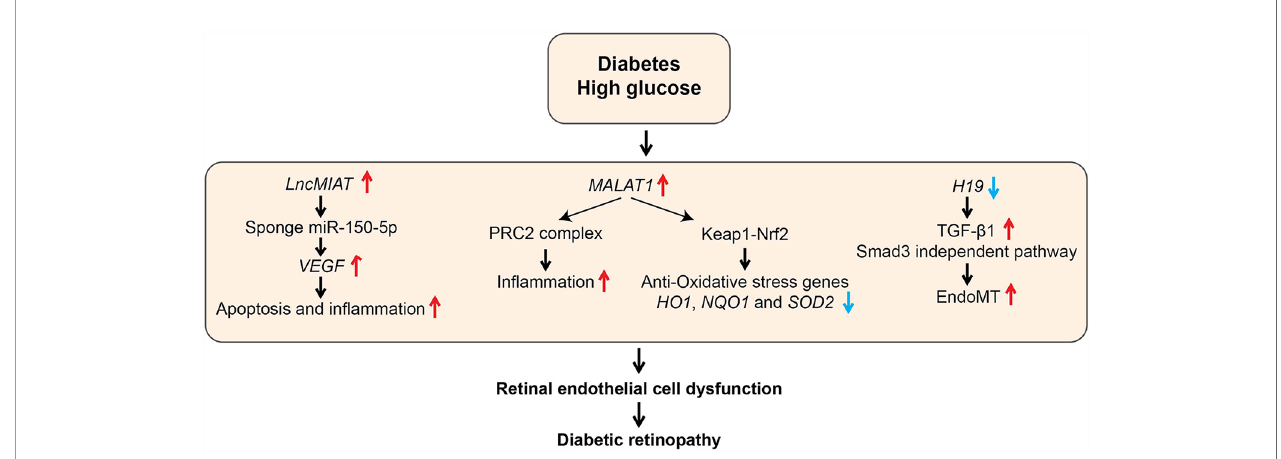
FIGURE 6 | Role of LncRNAs in diabetic retinopathy (DR). The schematic diagram shows the processes involved in the regulation of genes mediated by candidate lncRNAs during various pathological processes associated with DR. EndoMT, Endothelial to mesenchymal transition; HO1, Heme oxygenase-1; Keap1, Kelch Like ECH Associated Protein 1; NQO1, NAD(P)H Quinone Dehydrogenase 1; Nrf2, Nuclear factor erythroid 2-related factor2; PRC2, Polycomb Repressive Complex 2; SOD2, Superoxide dismutase 2; VEGF, Vascular Endothelial Growth